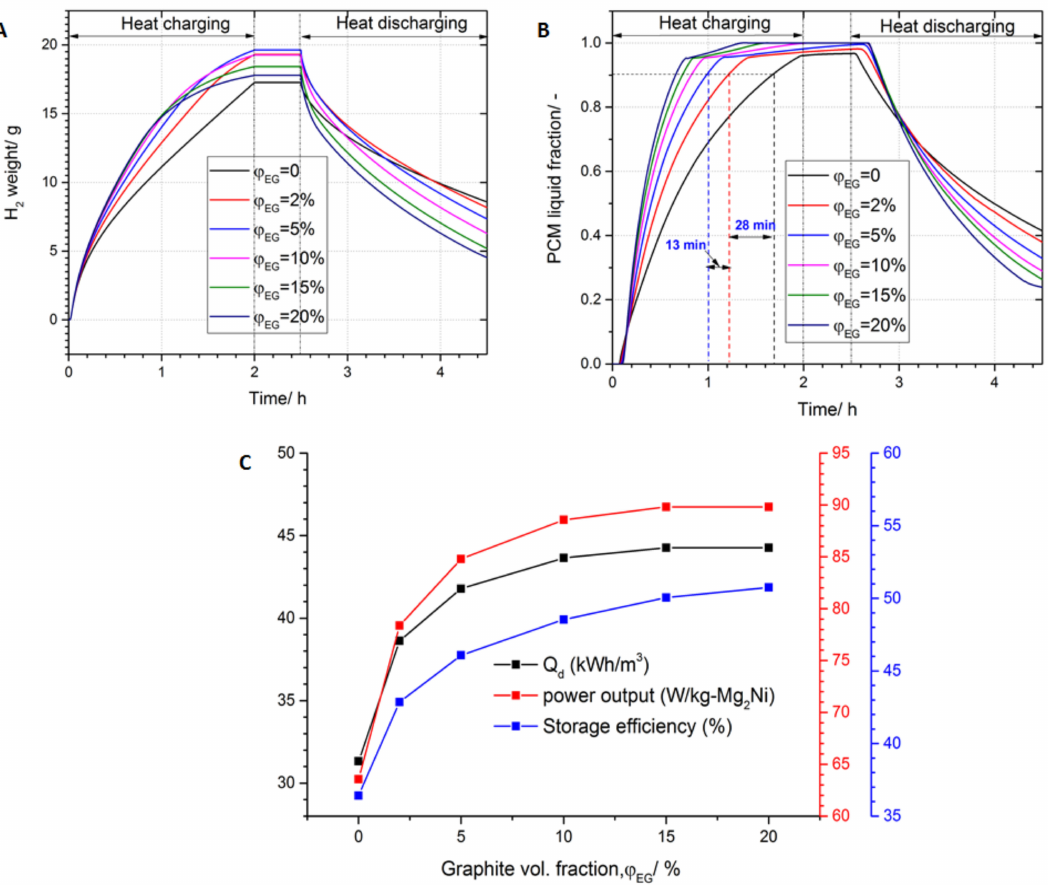
Figure 5. The e ff ects of enhancing the PCM thermal conductivity by addition of expanded graphite on ( A ) the H 2 weight absorbed / desorbed by the LTMH bed. ( B ) the PCM liquid fraction in the jacket. ( C ) performance indexes of the heat storage